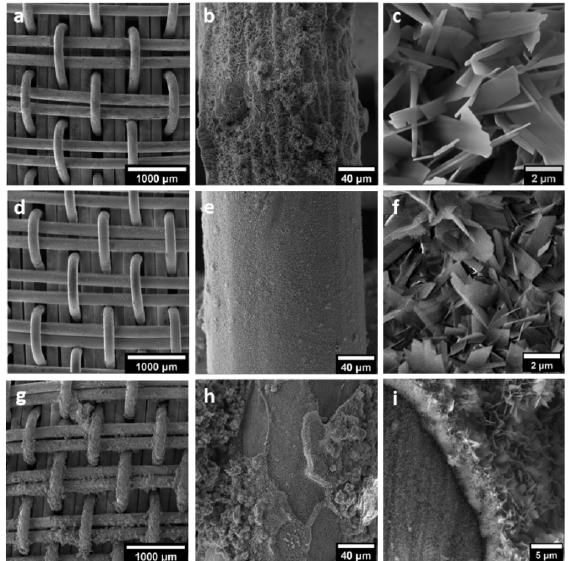
Figure 3. SEM micrographs showing the morphology of HAp formed on SS 3D-woven lattices under deposition potentials of − 1.3 ( a – c ), − 1.5 ( d – f ), and − 1.7 V ( g – i ).